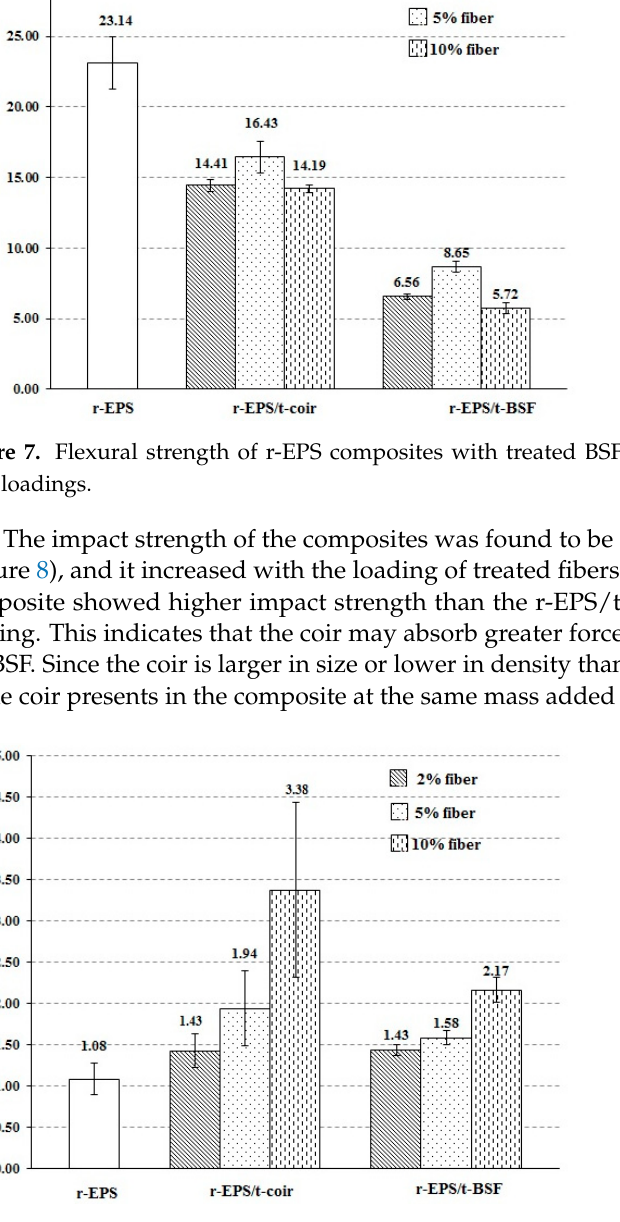
Figure 8. Impact strength of r-EPS composites with treated BSF or coir at 2%, 5%, or 10% wt. fiber loadings.